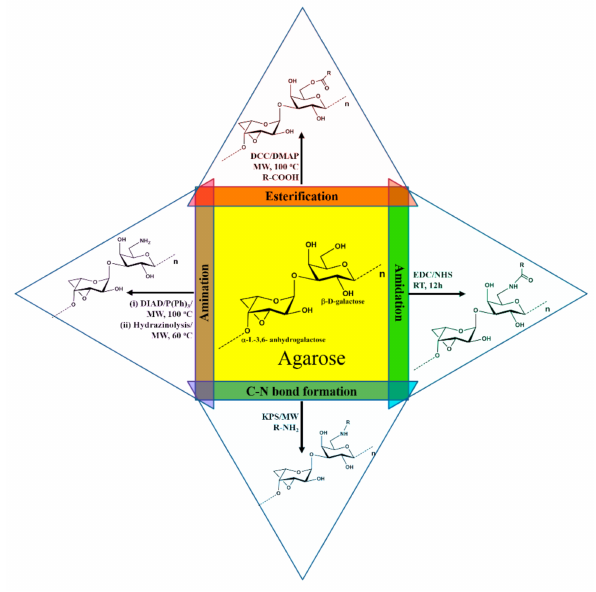
Figure 2. Derivatization of agarose via esterification, amination, amidation, and C-N bond formation